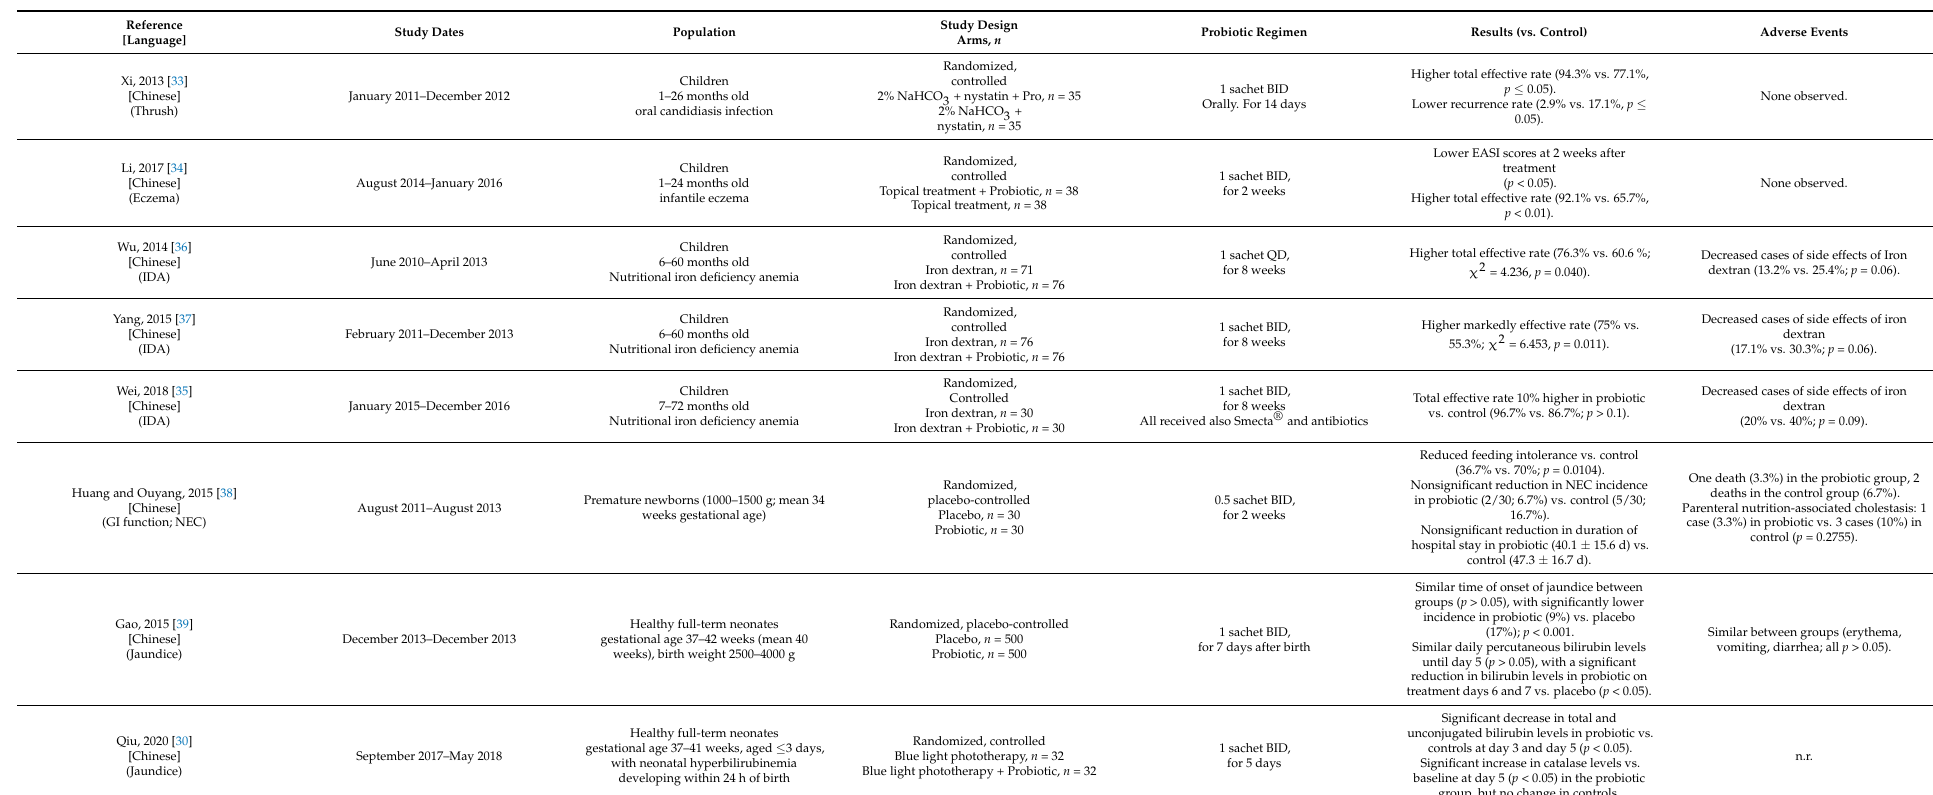
Table 3. Details of studies in other